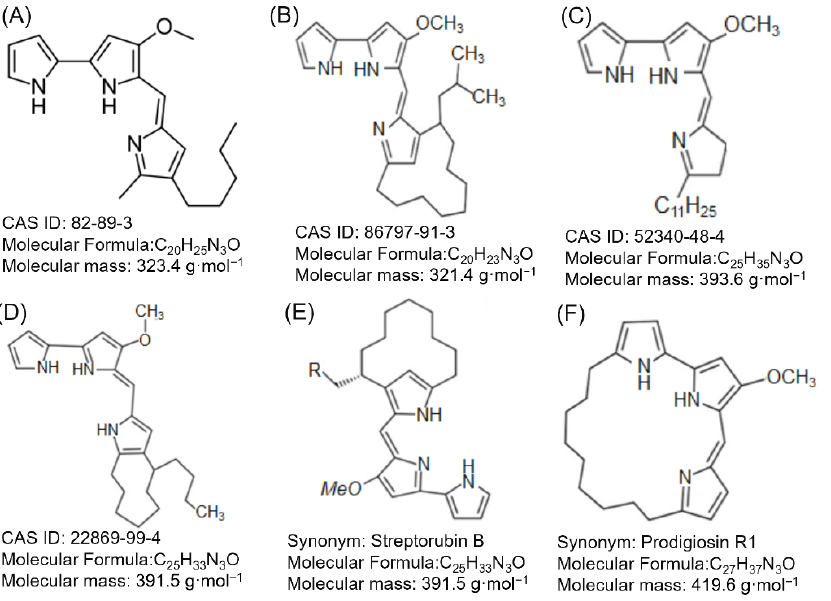
Figure 3. Examples of natural prodiginines: Prodigiosin ( A ), Cycloprodigiosin ( B ), Undecylprodigiosin ( C ), Metacycloprodigiosin ( D ), Butyl-meta-cycloprodigiosin ( E ), and Prodigiosin R1 ( F ).